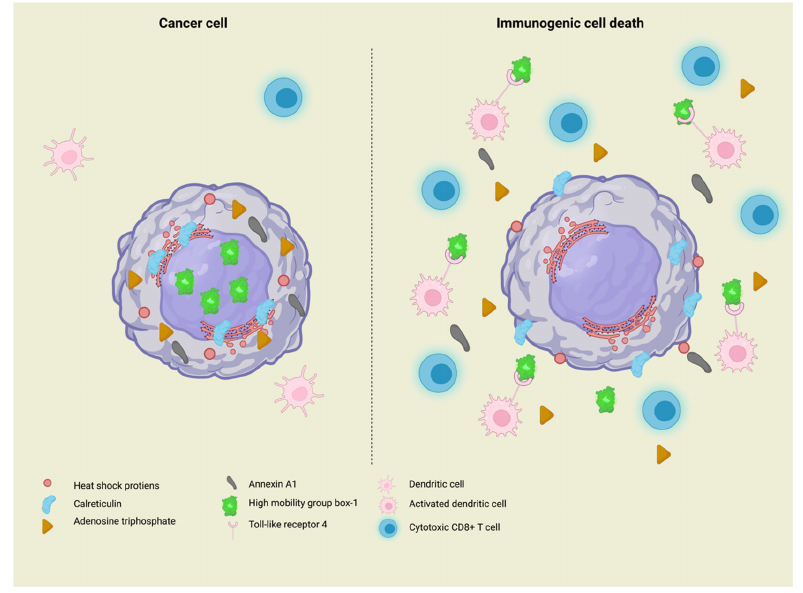
Figure 2. Schematic representation of immunogenic cell death (ICD). Cancer cells undergoing ICD release damage-associated molecular patterns. In particular, they expose the endoplasmic reticulum protein calreticulin and heat shock proteins on the plasma membrane and release cytosolic adenosine triphosphate, cytosolic annexin A1 protein, and nuclear high-mobility group box-1 (HMGB-1) in the extracellular space. Moreover, dendritic cells become activated and, due to the expression of Toll-like receptor 4, bind to the HMGB-1, now in the extracellular space. This results in the recruitment of cytotoxic CD8+ cells to the tumour site.